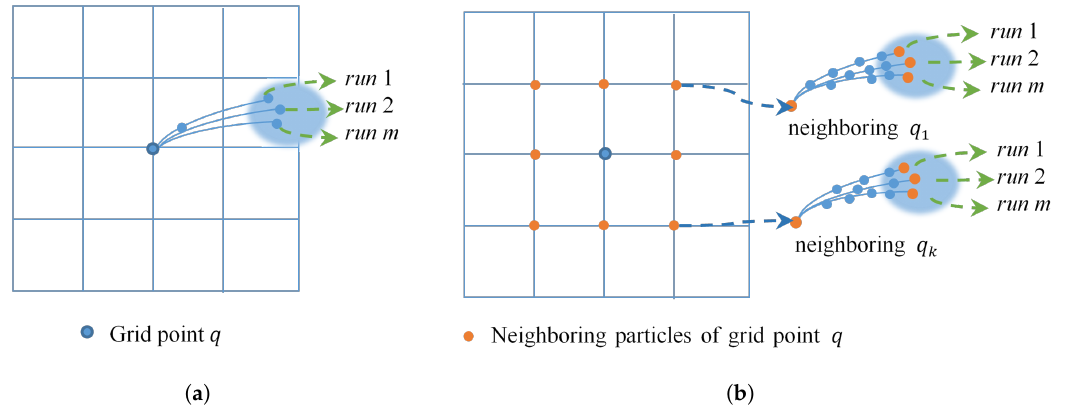
Figure 3. Pathline tracing of single location and neighborhood: ( a ) Pathline tracing of single location and ( b ) pathline tracing of